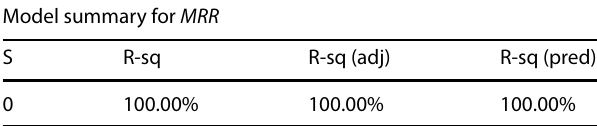
Table 17 Model summary for R Model summary for R